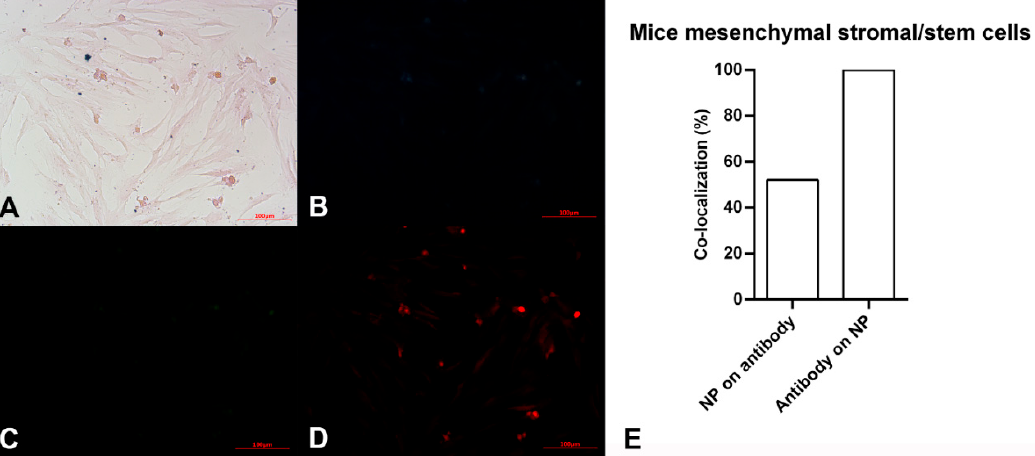
Figure 3. Microscopy images of mouse mesenchymal stromal/stem cells after exposing to Alexa Flour 594 anti-Oct4 antibody-conjugated nanoparticles using ( A ) brightfield, ( B ) blue filter, ( C ) green filter, and ( D ) red filter. ( E ) co-localization of conjugated iron nanoparticle staining and anti-Oct4 antibody in mouse mesenchymal stromal/stem cells. Columns show Manders’ coefficients expressed as percent values.